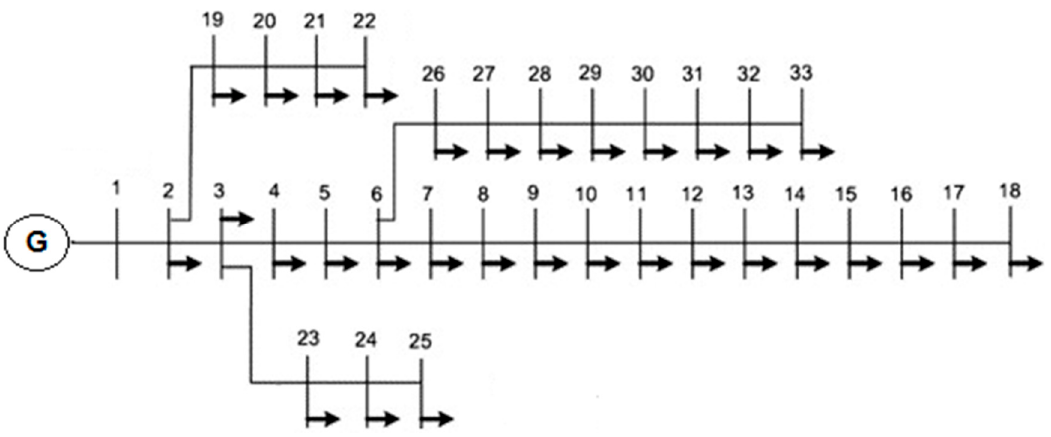
Figure 2. Single line diagram of the IEEE 33-bus radial distribution system [20]. Table 1. Line data of the IEEE 33-bus radial distribution system [20].